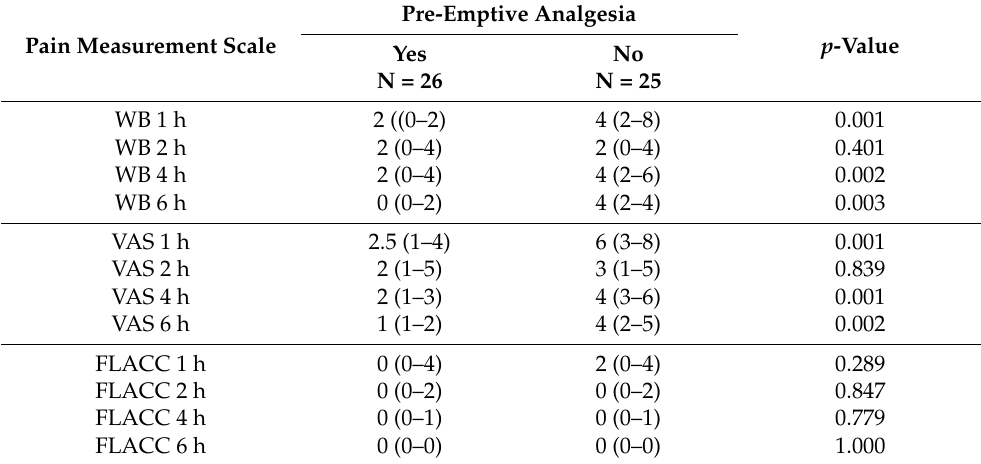
Table 3. Assessment of perceived pain in groups of children differing in pain prophylaxis.